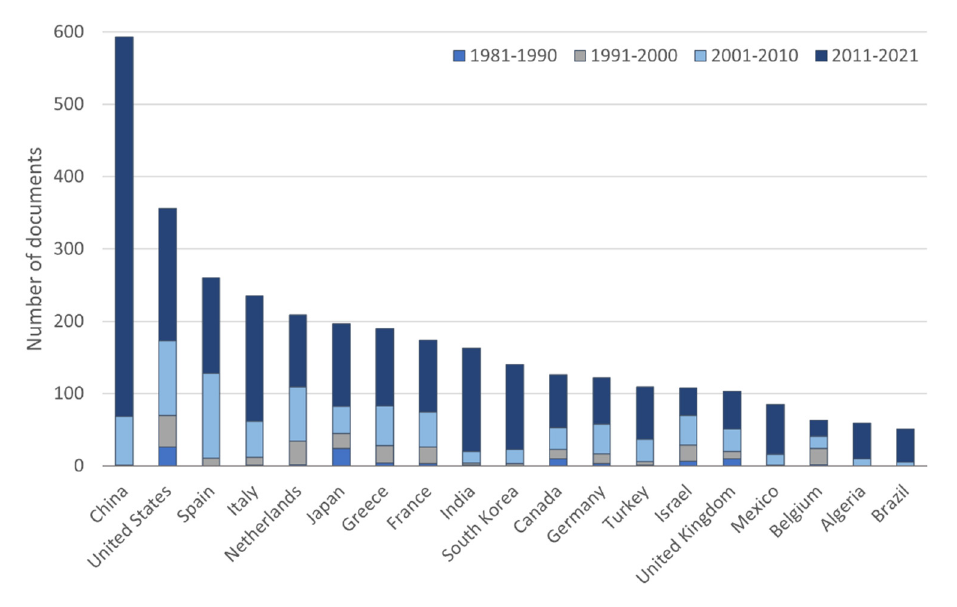
Figure 5. Countries publishing more than 50 articles related to greenhouse engineering from 1981 to 2021 (countries are related to the authors’ affiliations).